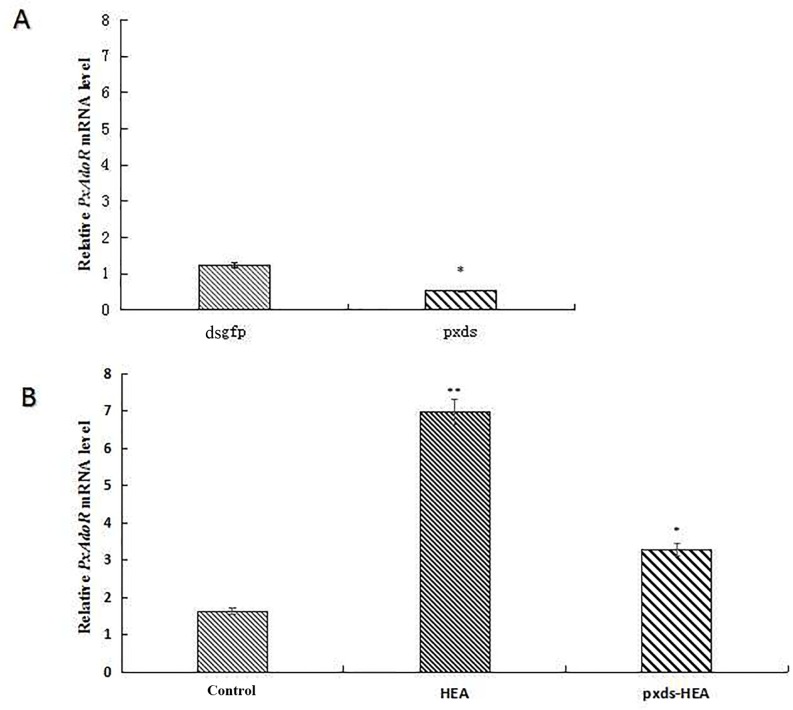
Relative PxAdoR mRNA level.(A) Effect of PxAdoR silencing by 500 ng/mL dsRNA feeding. (B) Effect of HEA feeding after silencing PxAdoR. Analyzed sample were cDNAs that were reverse-transcribed from pooled RNA samples of 10 larvae. Bars represent the means ± standard deviations of technical replicates. *P < 0.05; **P < 0.001 (A) compared with the dsgfp group. (B) compared with the control.